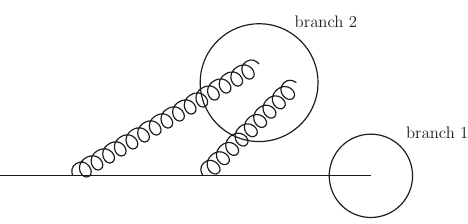
Figure 2. The configuration responsible for the independent emission clustering correction, where two soft emissions with z are de-clustered from the parent parton as a single branch which i < z cut as a whole passes the z cut